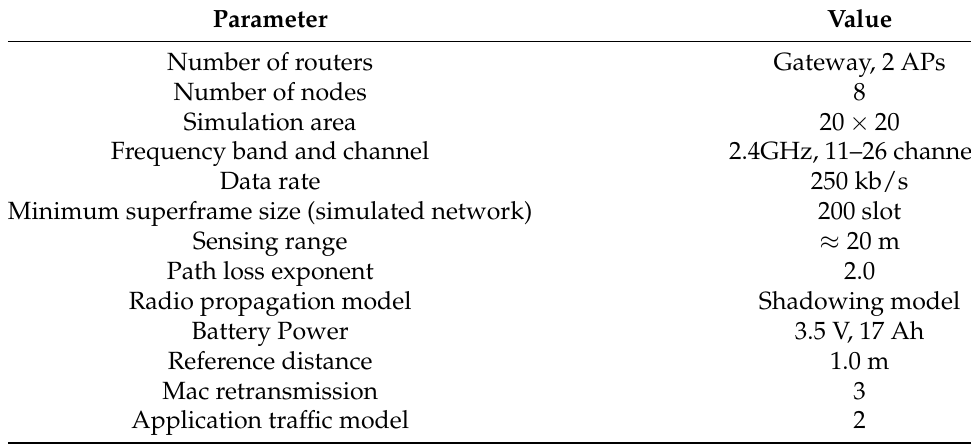
Table 3. Parameters of NS-2